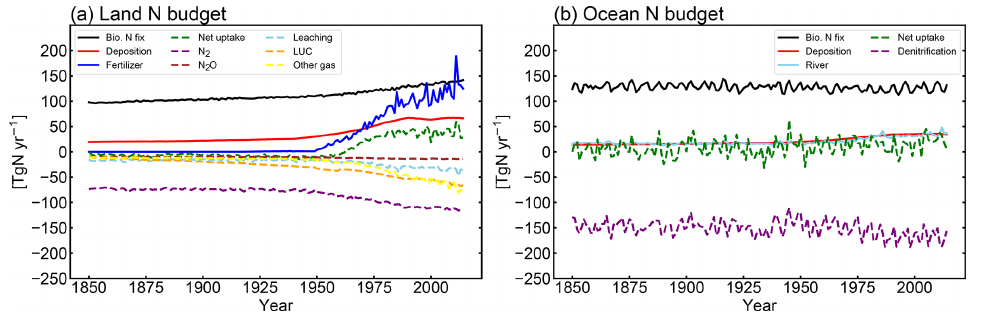
Figure 9. Rate of change of the global nitrogen budget in the (a) land and (b) ocean in the HIST simulation. Solid lines represent the nitrogen input into the land and ocean, and dashed lines represent its fate. Positive (negative) values mean a flux into (out of) the land and ocean. In panel (a) , BNF (black line) considers both natural and agricultural fluxes. LUC (dashed orange line) is an emission derived from the decay of biomass in the LUC product pools. Other gases (yellow line) represent the sum of NH 3 emissions and the flux from abiotic sources. For the ocean, denitrification (purple line) includes both N 2 and N 2 O emissions. The rate of nitrogen loss by the sedimentation process onto the ocean floor is not shown in the figure because of the small size of the flux ( < 0 . 015TgNyr − 1 ). All nitrogen gas emissions are diagnosed and thus have no effect on the radiative balance in the atmosphere or on air quality